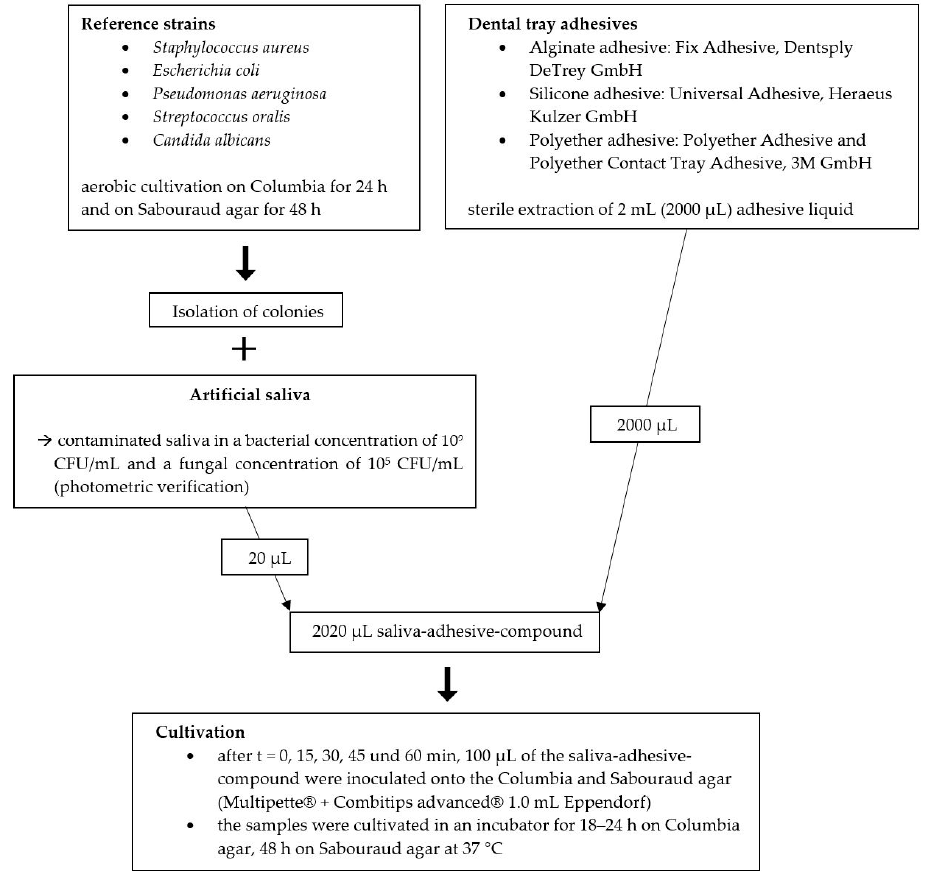
Figure 2. Overview of the materials and method.